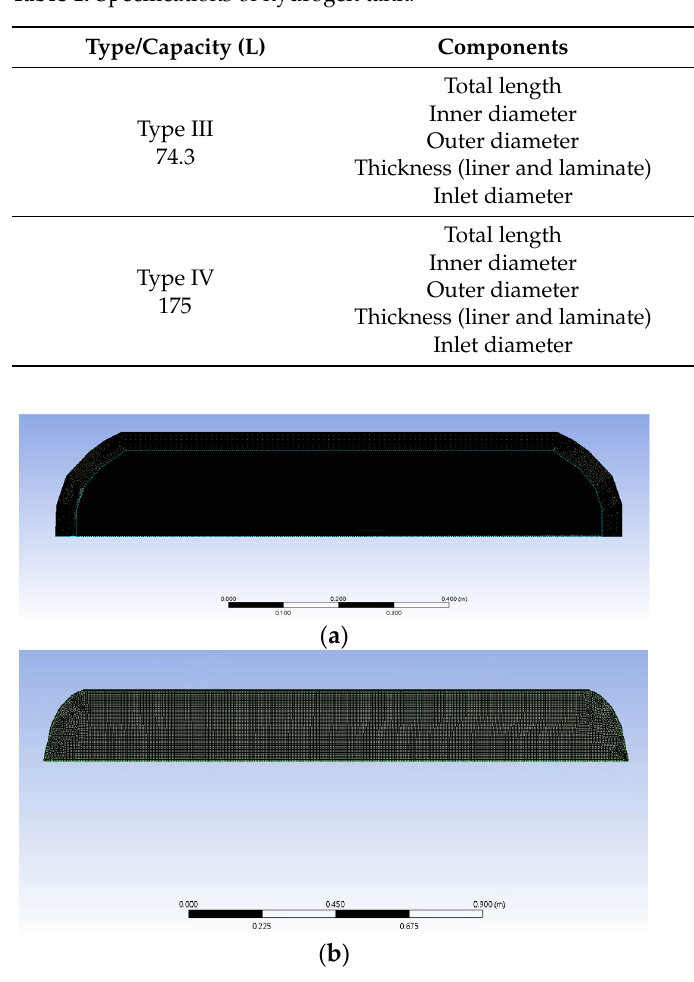
Figure 1. The mesh grid for the numerical analysis ( a ) Type Ⅲ ( b ) Type Ⅳ. Table 2. Material properties.